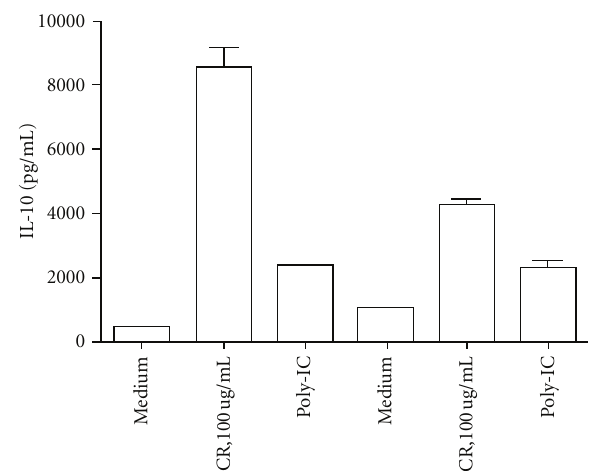
Figure 3: Cockroach allergen induced-IL-10 secretion in mDCs. IL- 10 production was detected in the cockroach-extract- (CR-) treated alone (100ug/mL) or together with anti-DC-SIGN mDCs. IL-10 levels were measured by